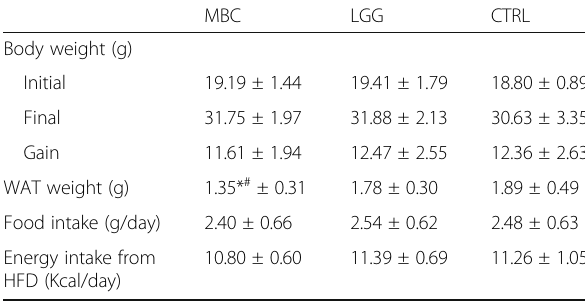
Table 2 Serum metabolic measurements in MBC, LGG, or